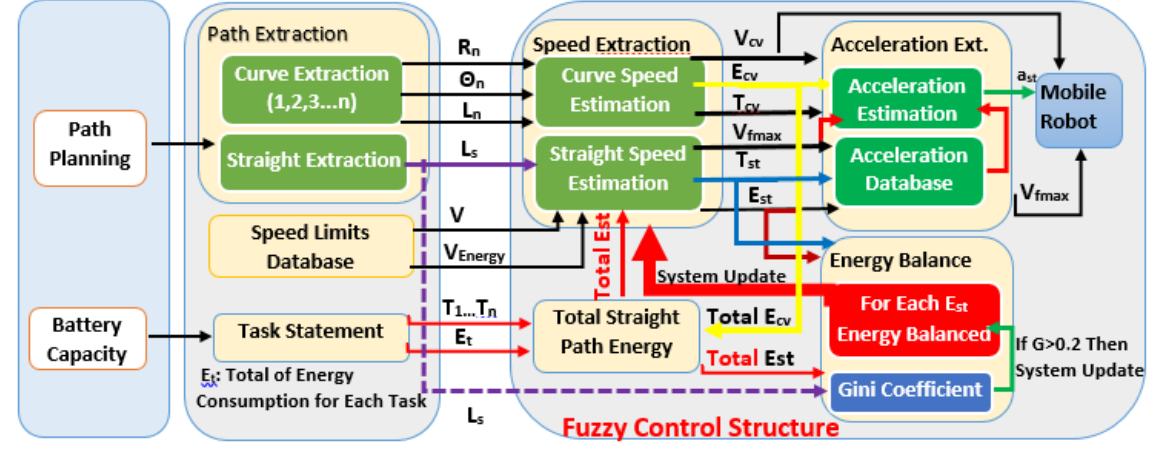
Figure 1. System block diagram .